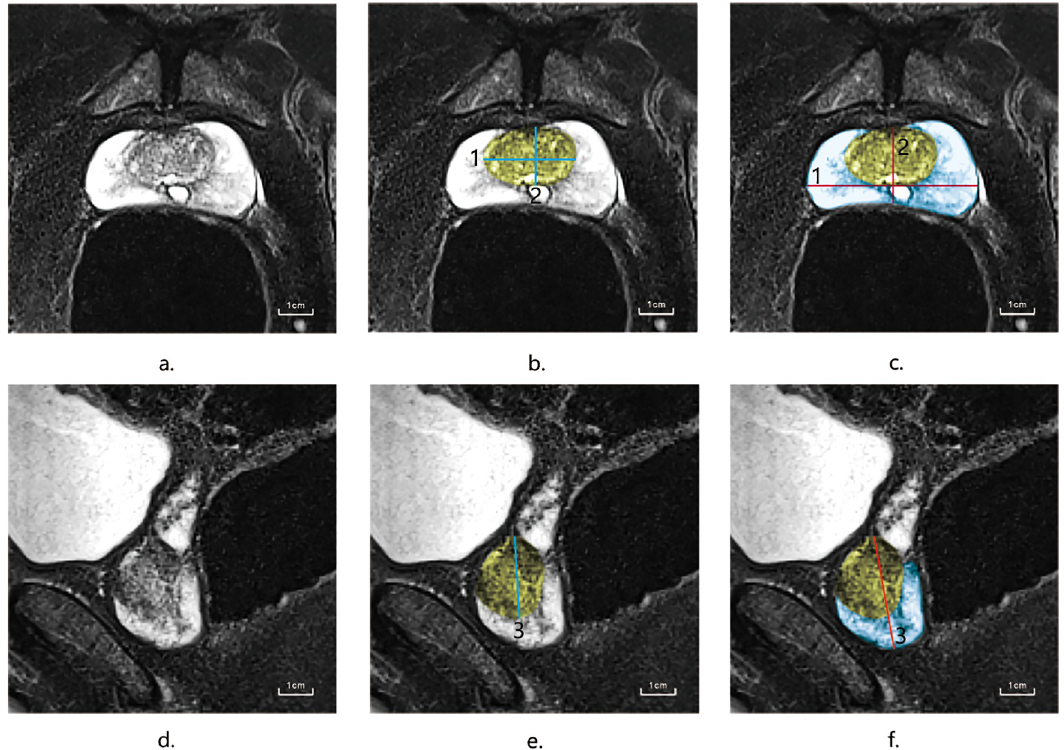
Fig 1. Prostate location and MR imagine plane. (Yellow: Transition zone; Blue: Peripheral zone.). (a, b, c.) Axial fat-saturated T2WI MR images of prostate. (d, e, f.) Sagittal fat-saturated T2WI MR images of prostate. (b, e.) Blue line (1, 2, 3.) depicting the width, height and length of transition zone. (c, f.) Red line (1, 2, 3.) depicting the width, height and length of